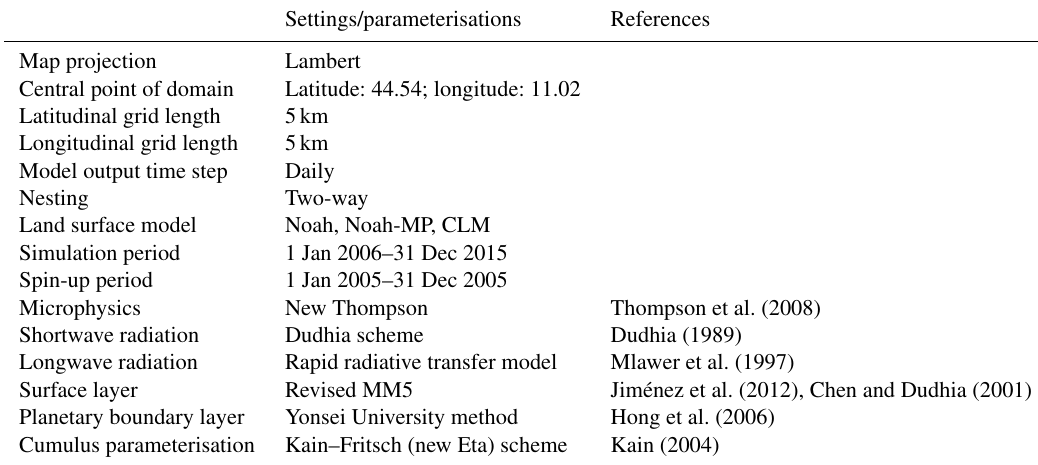
Table 2. WRF parameterisations used in this study.